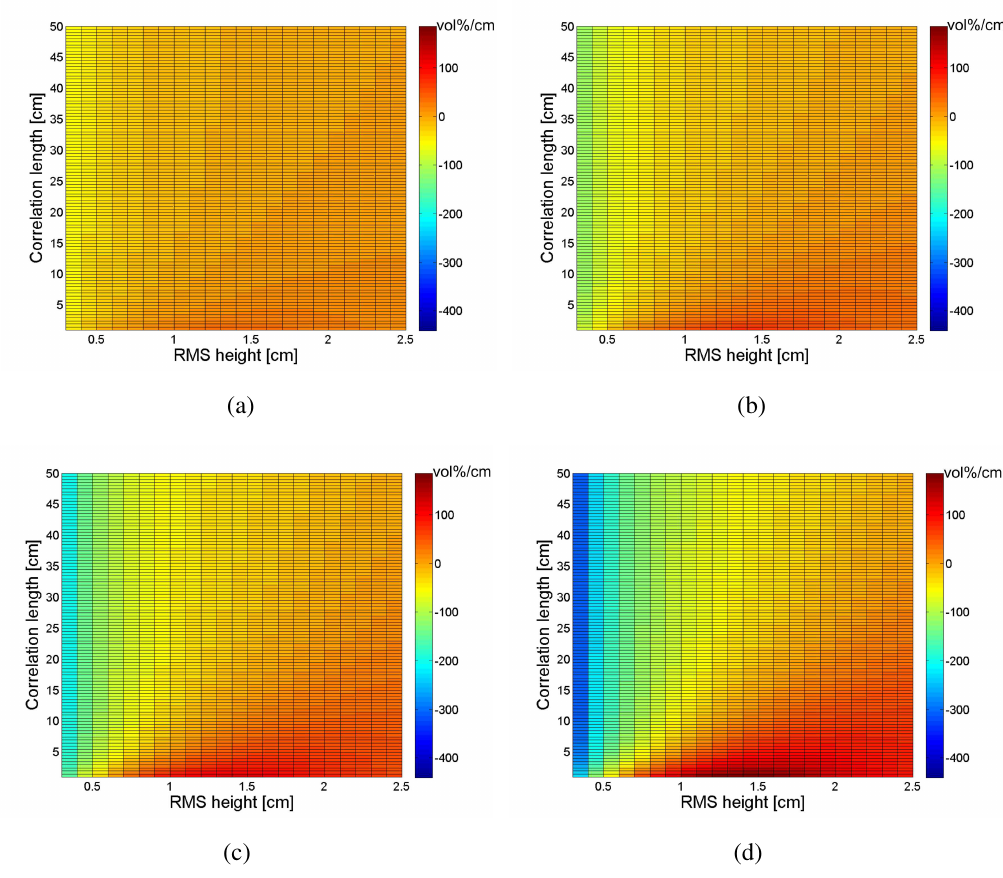
Figure 2. Sensitivity of the soil moisture retrieval to RMS height (vol%/cm) for an ASAR VV configuration and a moisture content of (a) 5 vol%, (b) 15 vol%, (c) 25 vol%, and (d) 35